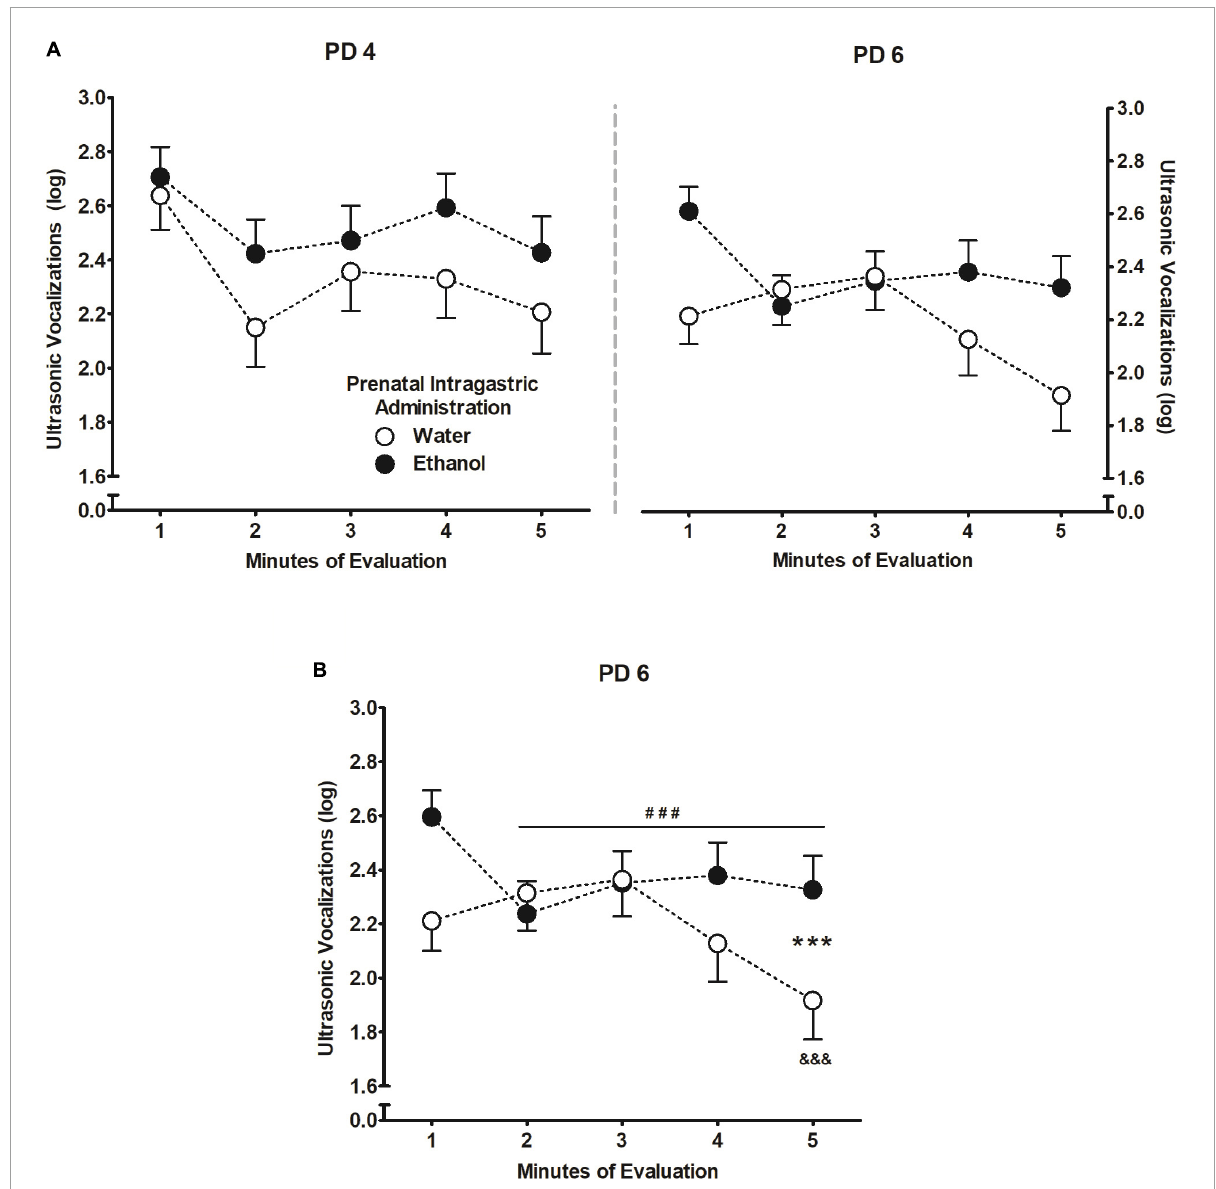
FIGURE5 Ultrasonic vocalizations (log) [bij = log (ultrasonic vocalizations + 1)]. (A) During PDs 4 and 6. (B) As a function of prenatal intragastric administration of ethanol (black) or water (white) across minutes of evaluation at PD6. ### p < 0.001 indicates that pups prenatally exposed to ethanol exhibited significantly fewer vocalizations from the second minute of evaluation relative to the first minute and remained steady from minutes 3–5. &&& p < 0.001 refers to prenatally water-treated group exhibited fewer vocalizations during the last-minute relative to the first 4 min of evaluation. *** p < 0.001 represents the differences between pups prenatally exposed to ethanol and those water-treated within a time point. Vertical lines illustrate standard errors of the mean (SEMs).